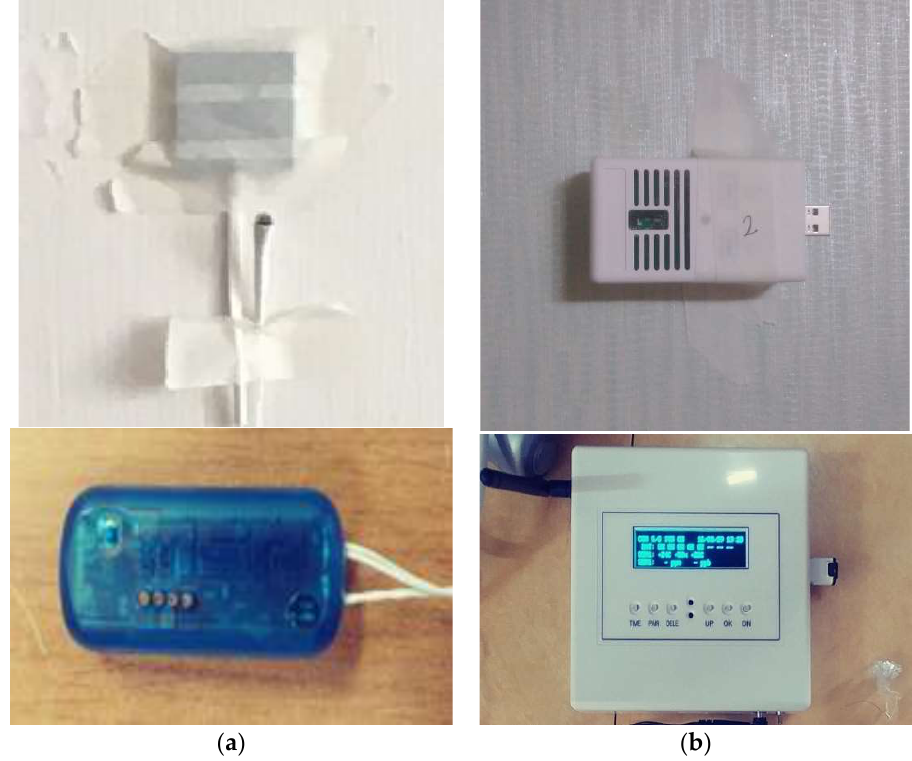
Figure 4. Installed in situ measurement equipment for calculations using the ( a ) heat flow meter and ( b ) the air-surface temperature ratio. ( b ) the air-surface temperature